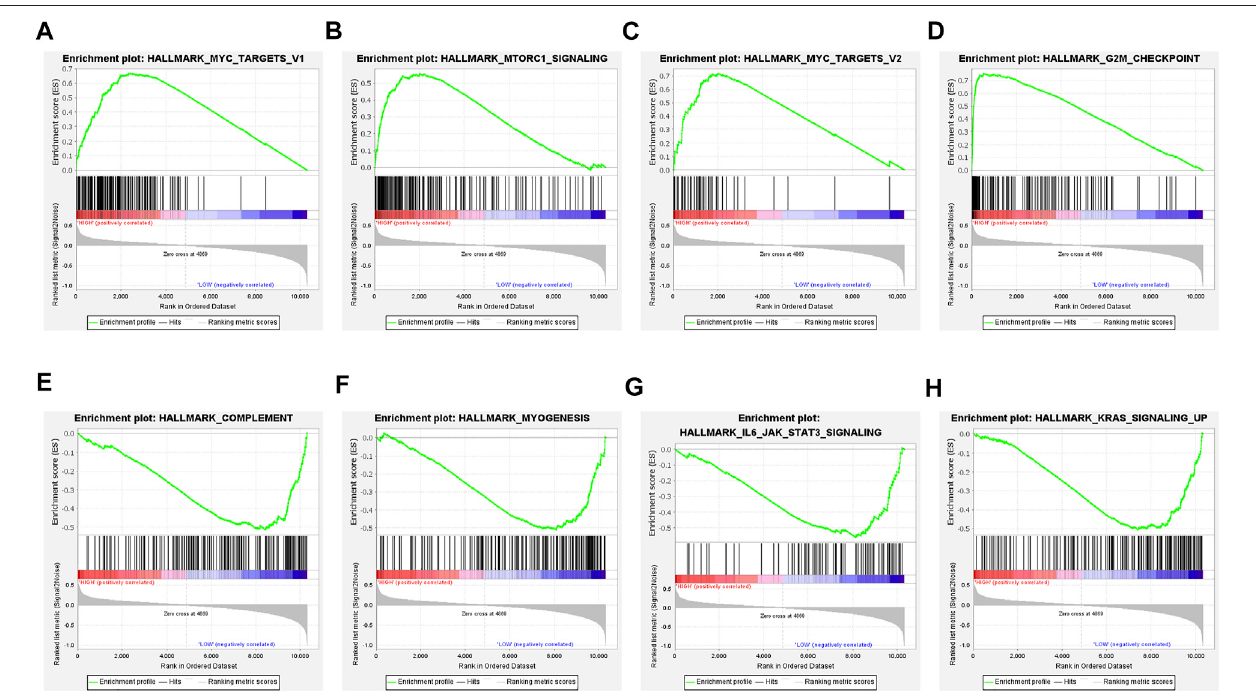
FIGURE4| Genesetenrichmentanalysis(GSEA)inTMEscoregroups. (A – D) EnrichmentplotsshowingMYCtargetsV1,MTORC1signaling,MYCtargetsV2,and G2Mcheckpoint inthe high-TMEscore group. (E – H) Enrichmentplots showing complement, myogenesis, IL6/JAK/STAT3 signaling, and KRAS signaling up inthe low- TMEscore